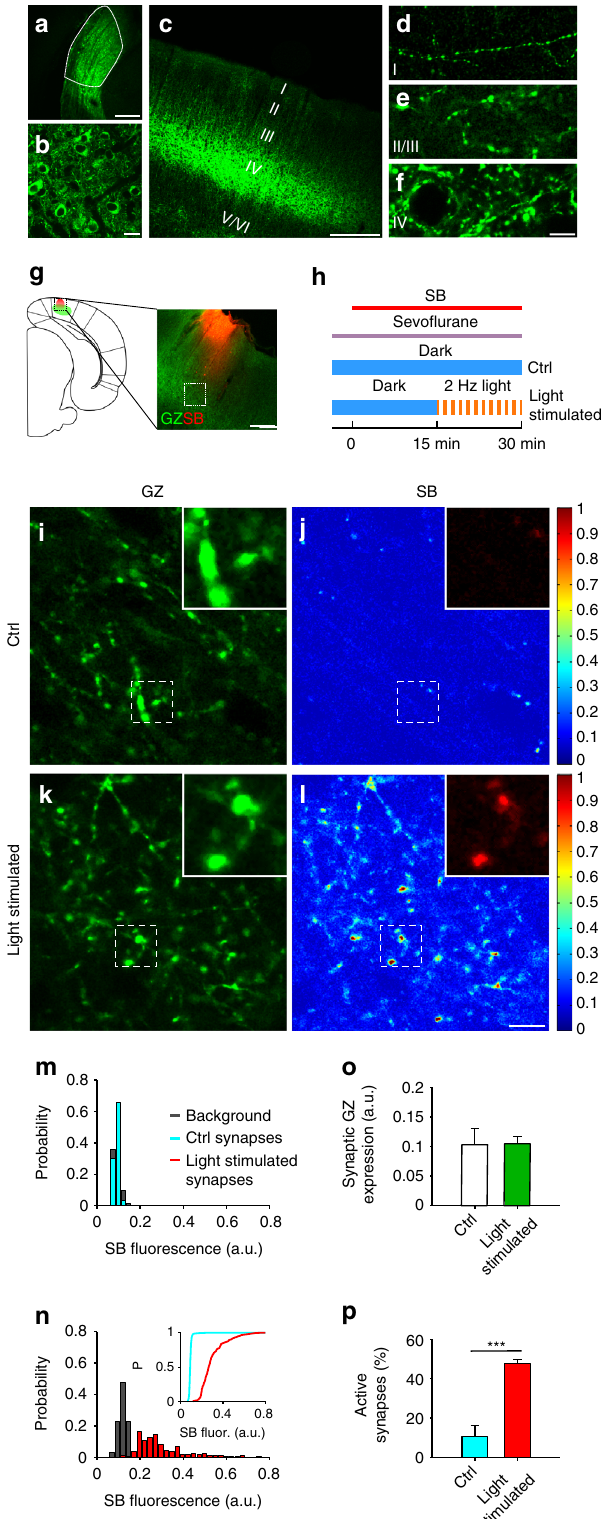
(B-H) correction; data from same experiments presented in Fig. 5c – h). As for V1 cortex, in the mPFC areas where synapses